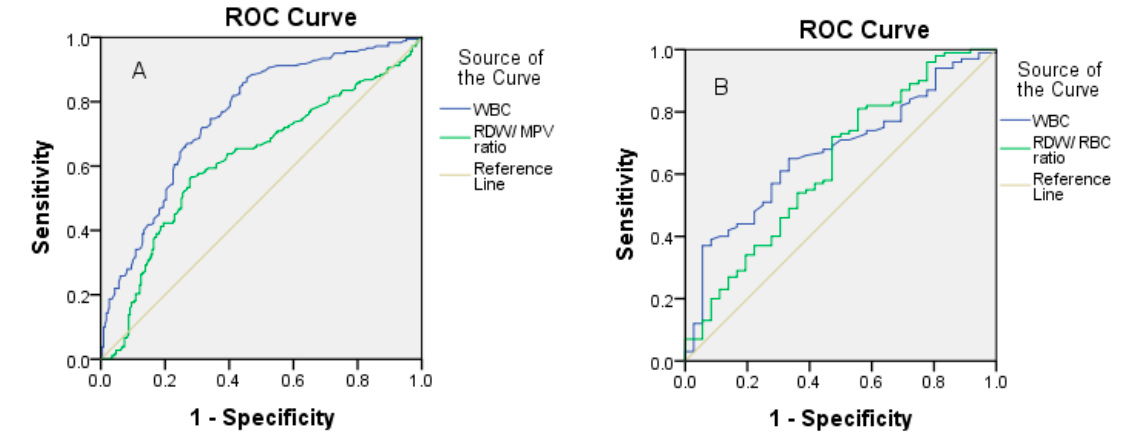
Figure 1. Receiver operating characteristic curves: ( A )—for WBC and RDW/MPV ratio in predicting acute appendicitis; ( B )—for WBC and RDW/RBC ratio in predicting complicated appendicitis.